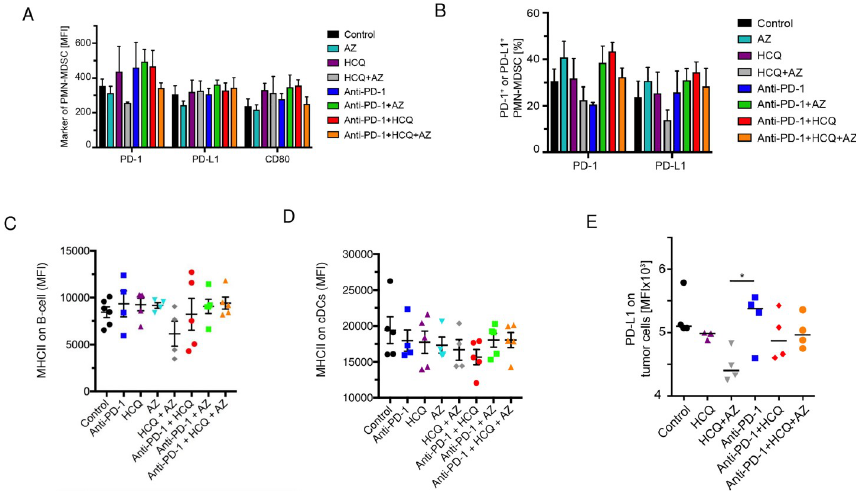
Fig 2. The effect of HCQ and AZ on the expression of PD1, PD-L1 and CD80 on TIL subsets. Panel A: Histogram showing the medium expression of PD1, PD-L1 and CD80 on PMN-MDSC TILs. Panel B: Histogram showing the percent positive PMN-MDSC TILs expressing PD1 and PD-L1. Panel C: The effect of therapy on MHC class II expression (MFI) on B cells. Panel D: The effect of therapy on MHC class II expression (MFI) on cDCs. Panel E: The effect of HCQ and HCQ/AZ on the anti-PD-1 induced increase in PDL-1 expression in vitro cultured B16